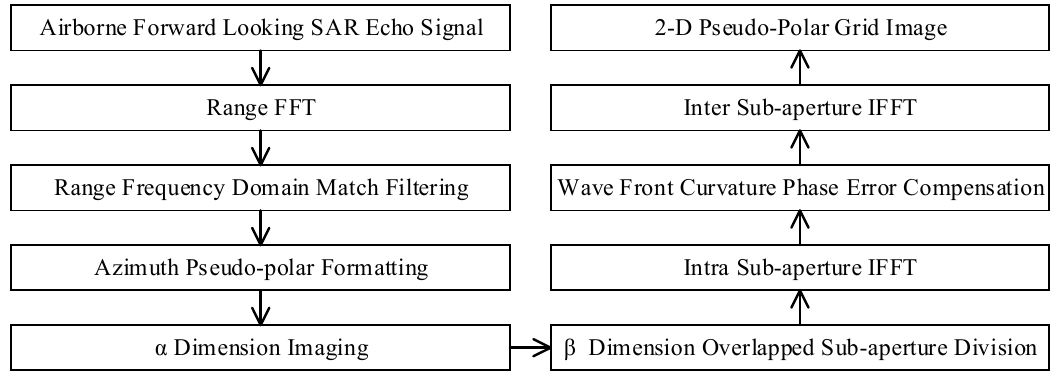
Figure 5. The flow diagram of the imaging algorithm with the combination of pseudo-polar formatting and overlapped sub-aperture algorithm.